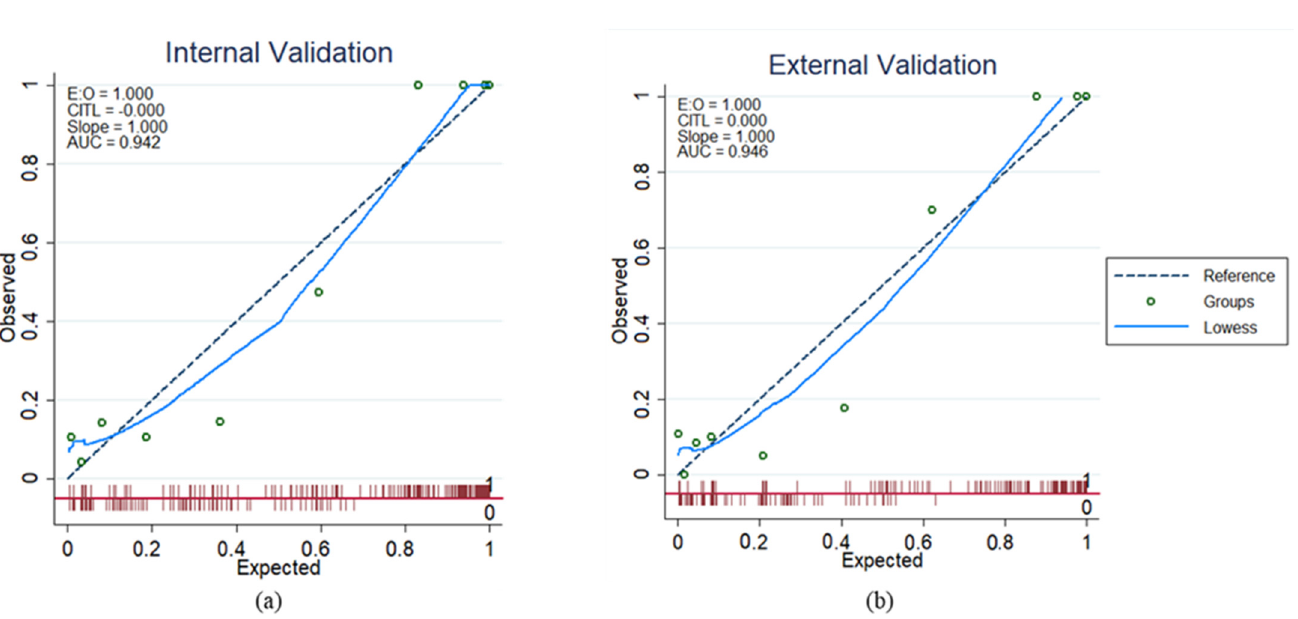
Figure 4. Decision curve analysis of different models for predicting DSPN severity. Figure 5 shows the nomogram generated using multivariate logistic regression for DSPN probability prediction utilizing the top-7 MNSI features. The nomogram spreads over 10 rows. The top 1–7 rows represent seven MNSI variables, together with a scale indicating the corresponding responses. The eighth row is the score scale for the responses of the seven variables. Row 9 is the probability axis indicating the probability of DSPN in patients based on the MNSI responses. Row 10 is the total score scale, where all the scores for each MNSI response are added to calculate the final score. Figure 6 demonstrates an